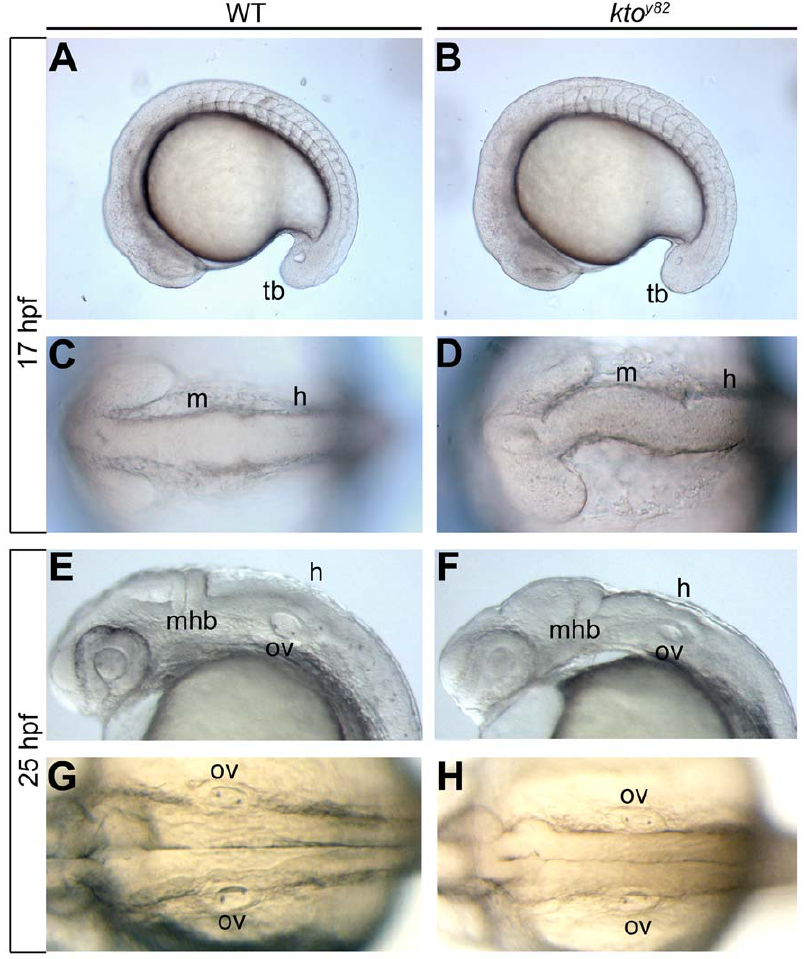
Figure 1. The hindbrain phenotype of kto y82 . Live images of lateral (A,B,E,F) and dorsal views (C, D, G, H) of the developing hindbrain at 17 hpf (A–D) and 25 hpf (E–H). The early midbrain and hindbrain regions are malformed at 17 hpf in mutant embryos (D), and no ventricle is visible at 25 hpf (H). h, hindbrain; m, midbrain; mhb, mid-hindbrain boundary; ov, otic vesicle; tb, tail bud.